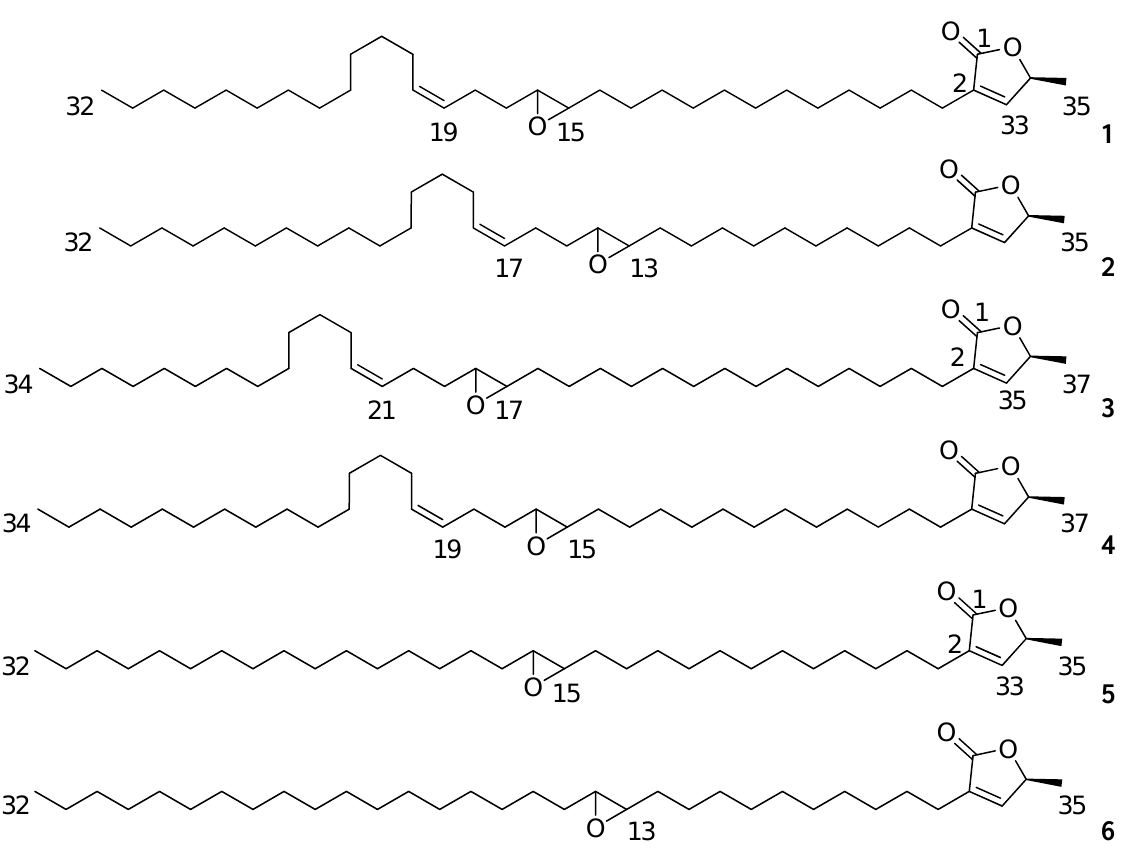
Figure 3. Obtained ACGs: Epomuricenins-A ( 1 , epoxymurin-A) and -B ( 2 ); Epomusenins- A ( 3 ) and -B ( 4 ); Epomurinins-A ( 5 ) and -B ( 6